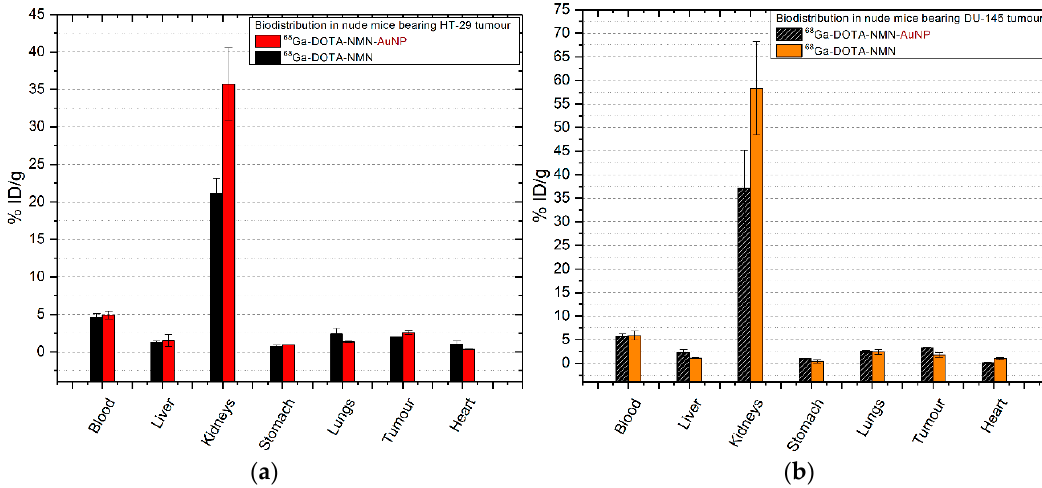
Figure 8. Comparative ex vivo biodistribution after 30 min post-injection of 68 Ga-DOTA-NMN / 68 Ga-DOTA-NMN-AuNP: ( a ) in nude mice bearing colon tumour; ( b ) in nude mice bearing prostate tumour. Data are presented as mean ± SD ( n = 4).